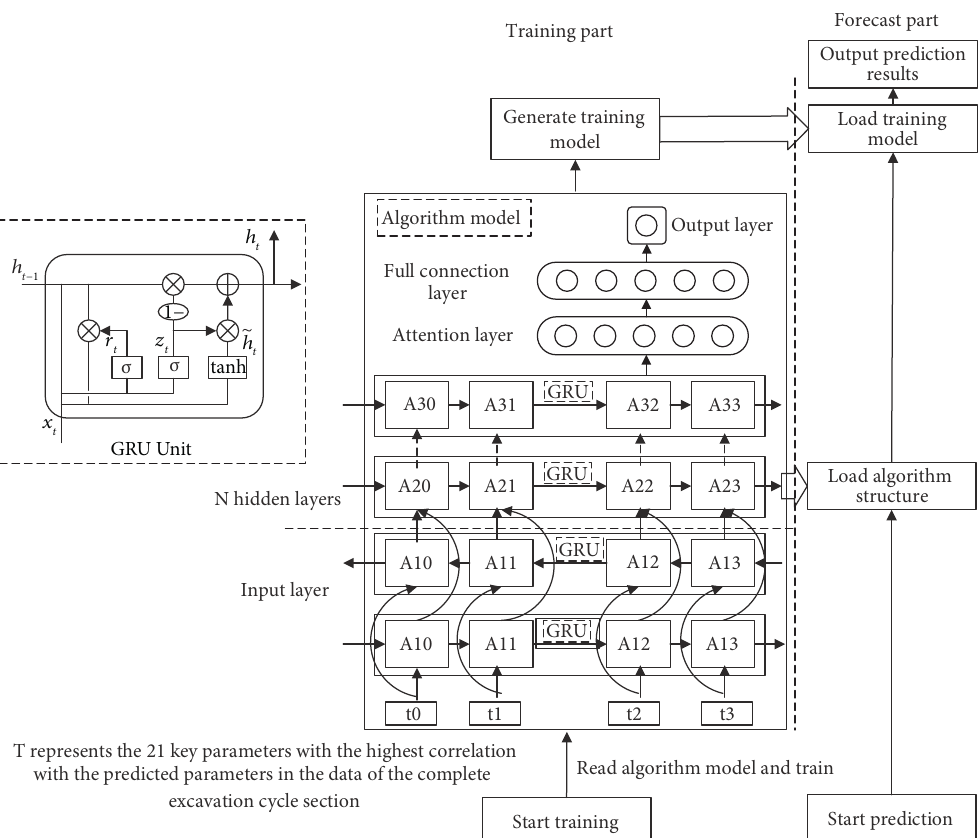
Figure 4: TBM tunneling parameter prediction model based on